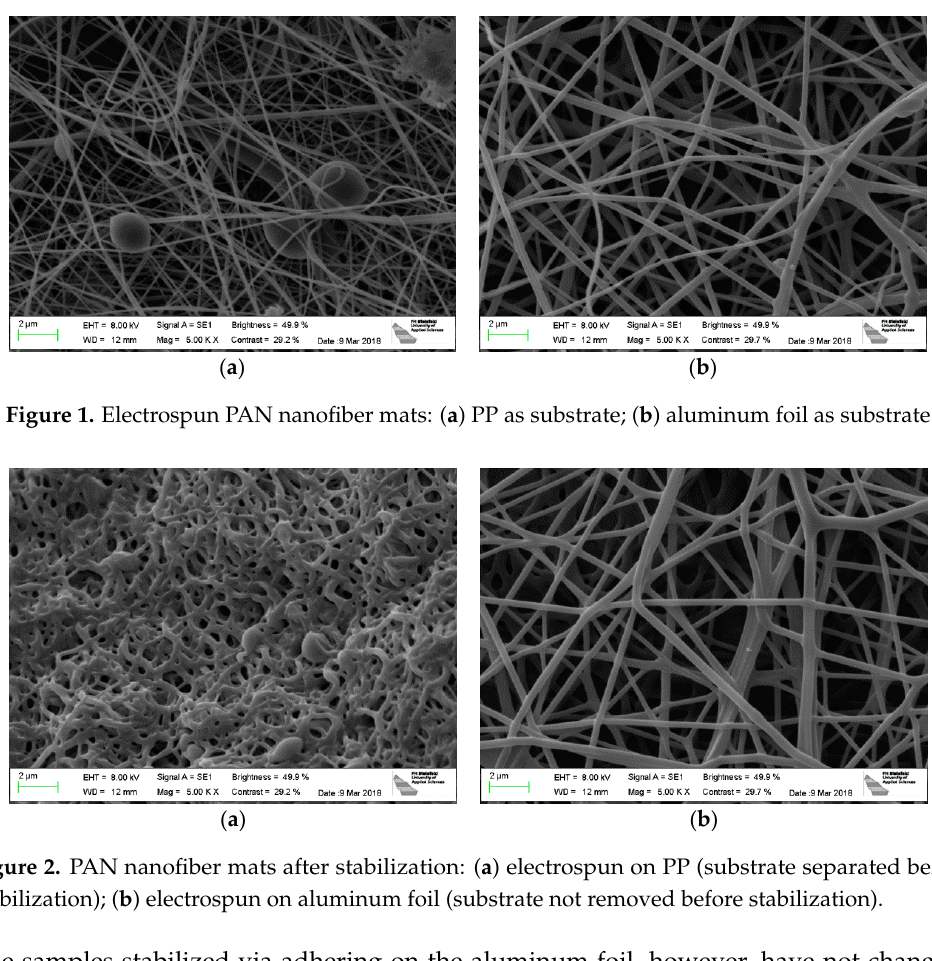
Figure 2. PAN nanofiber mats after stabilization: ( a ) electrospun on PP (substrate separated before stabilization); ( b ) electrospun on aluminum foil (substrate not removed before stabilization).